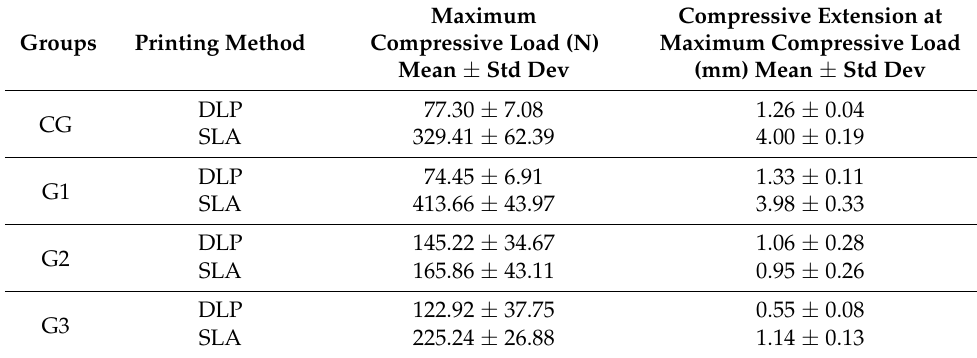
Table 5. Mean and standard deviations of the maximum compressive load and compressive extension at the maximum compressive load for the tested surgical